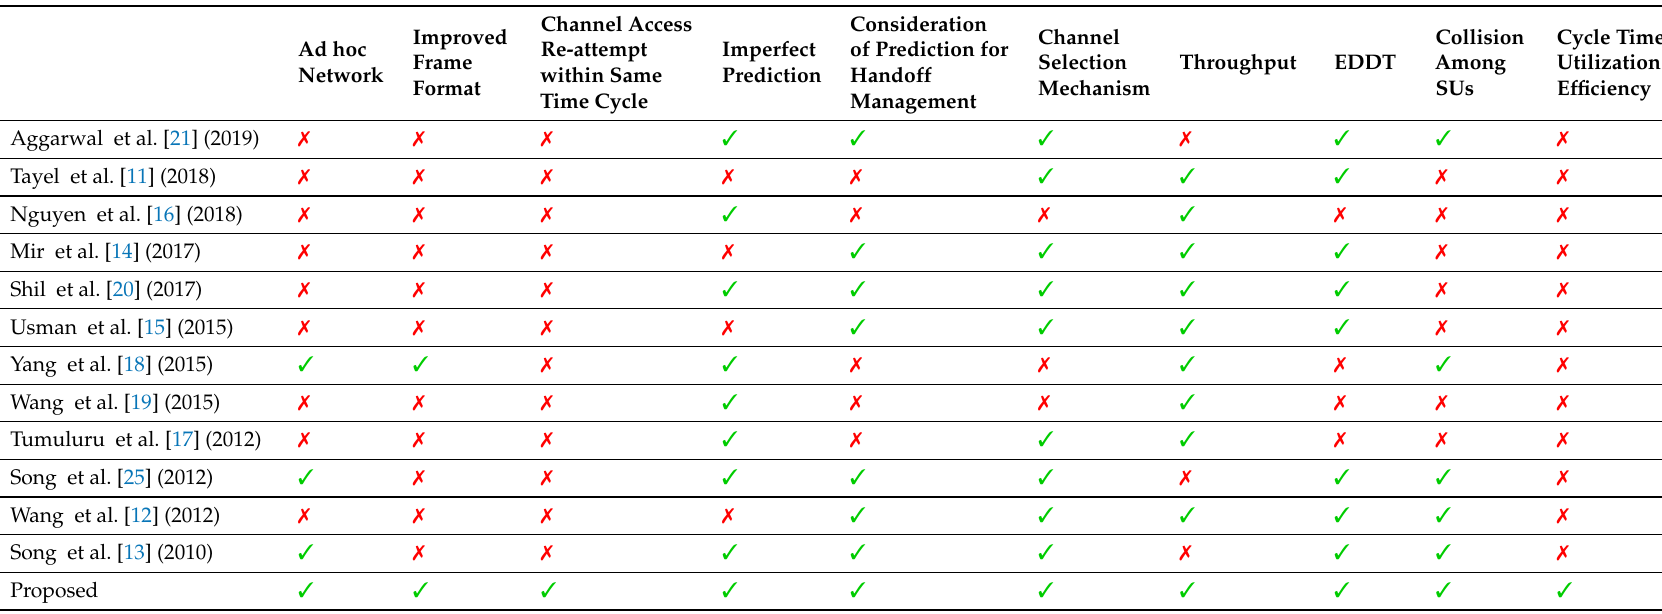
Table 1. Comparison of related work and proposed work in terms of imperfect spectrum prediction based spectrum handoff with collision reduction in CRAHN. Ad